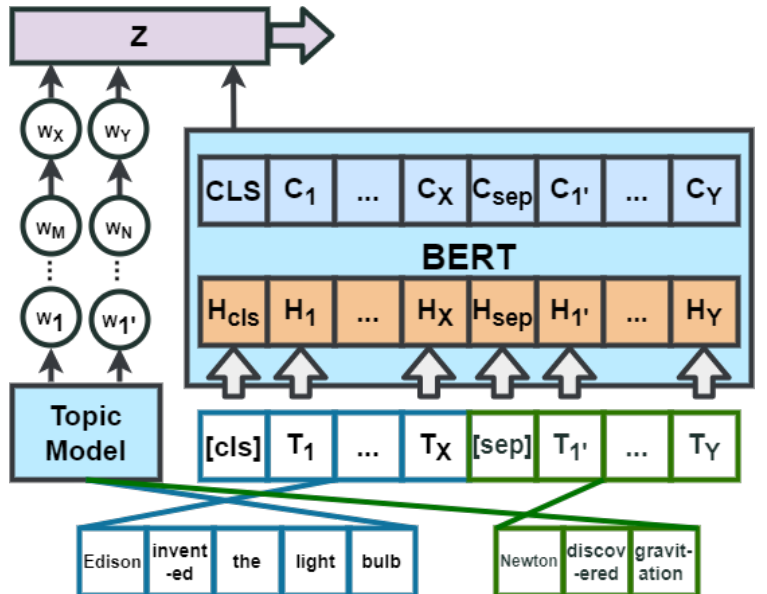
Figure 5. An illustration of tBERT’s architecture and the process of tokens converting to topic